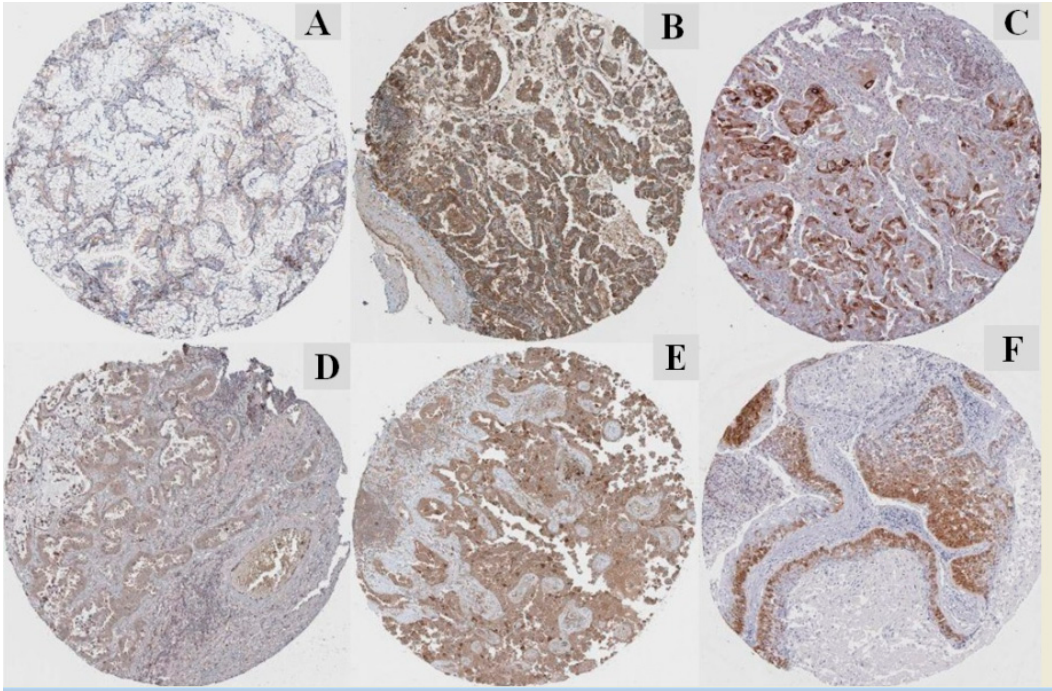
Figure 10. Immunohistochemistry of the PTGs based on the Human Protein Atlas database (HPAD). ( A ) Median staining of EFNA4 in LUAD (antibody: CAB021350; magnification of 4 ×